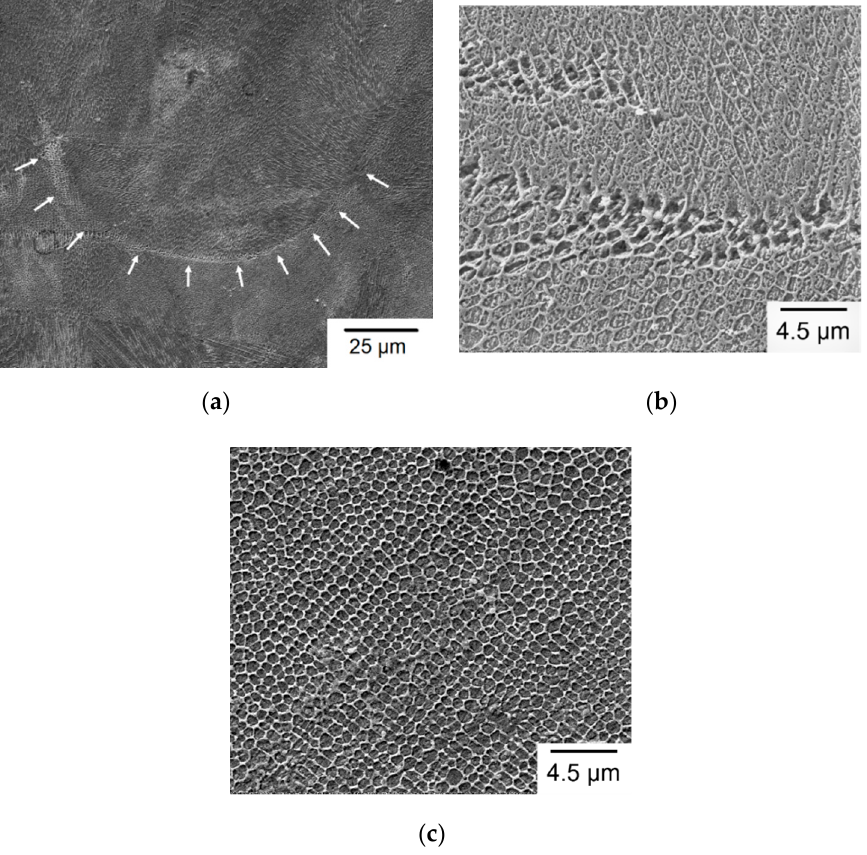
Figure 12. Representative SEM micrographs of melt pool: ( a ) Low-magnification view of vertical cross-section; ( b ) high-magnification view of melt pool boundary in vertical cross-section; ( c ) high-magnification view of melt pool center in horizontal cross-section.